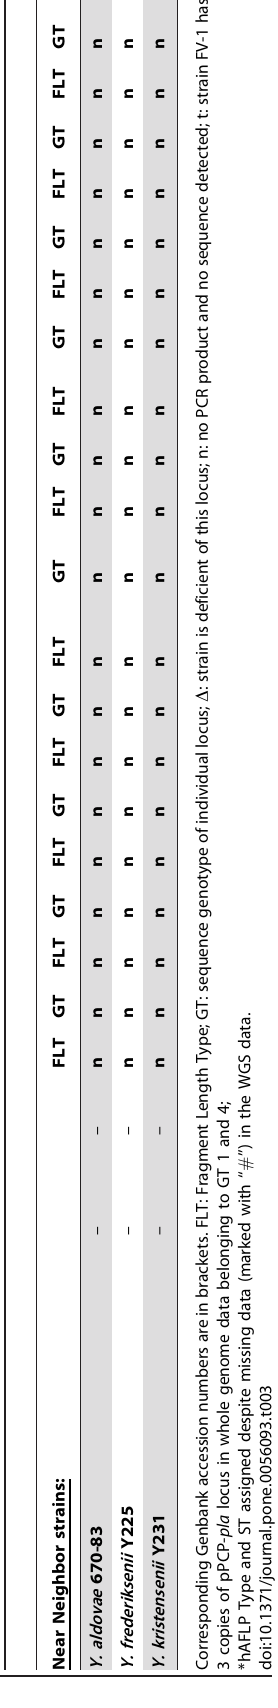
on t C 3 . e b l a T